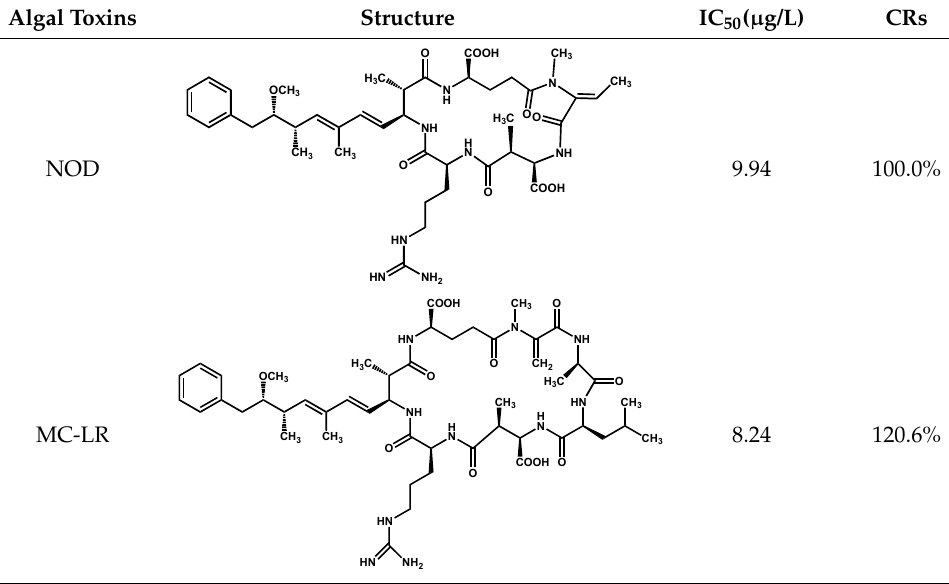
Table 2. CRs of N56 for MCs analogues ( n = 3).